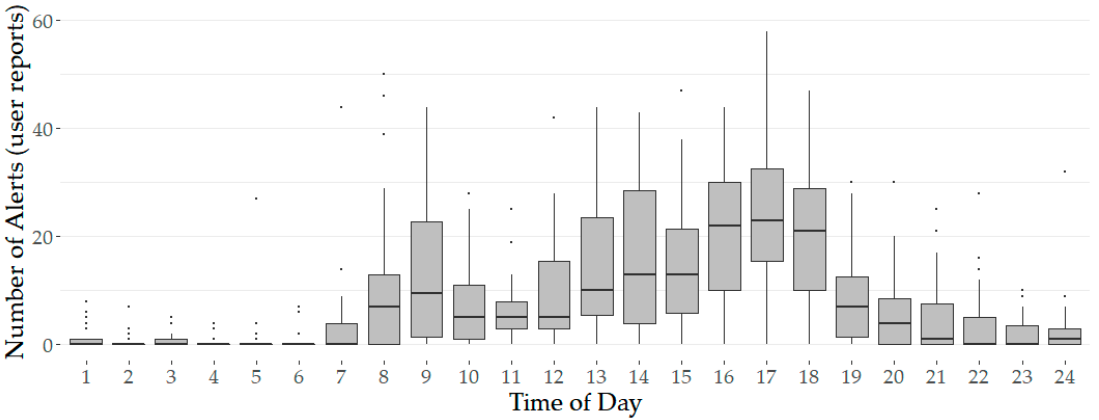
Figure 4. Boxplot of the number of alerts in each time period (hours).